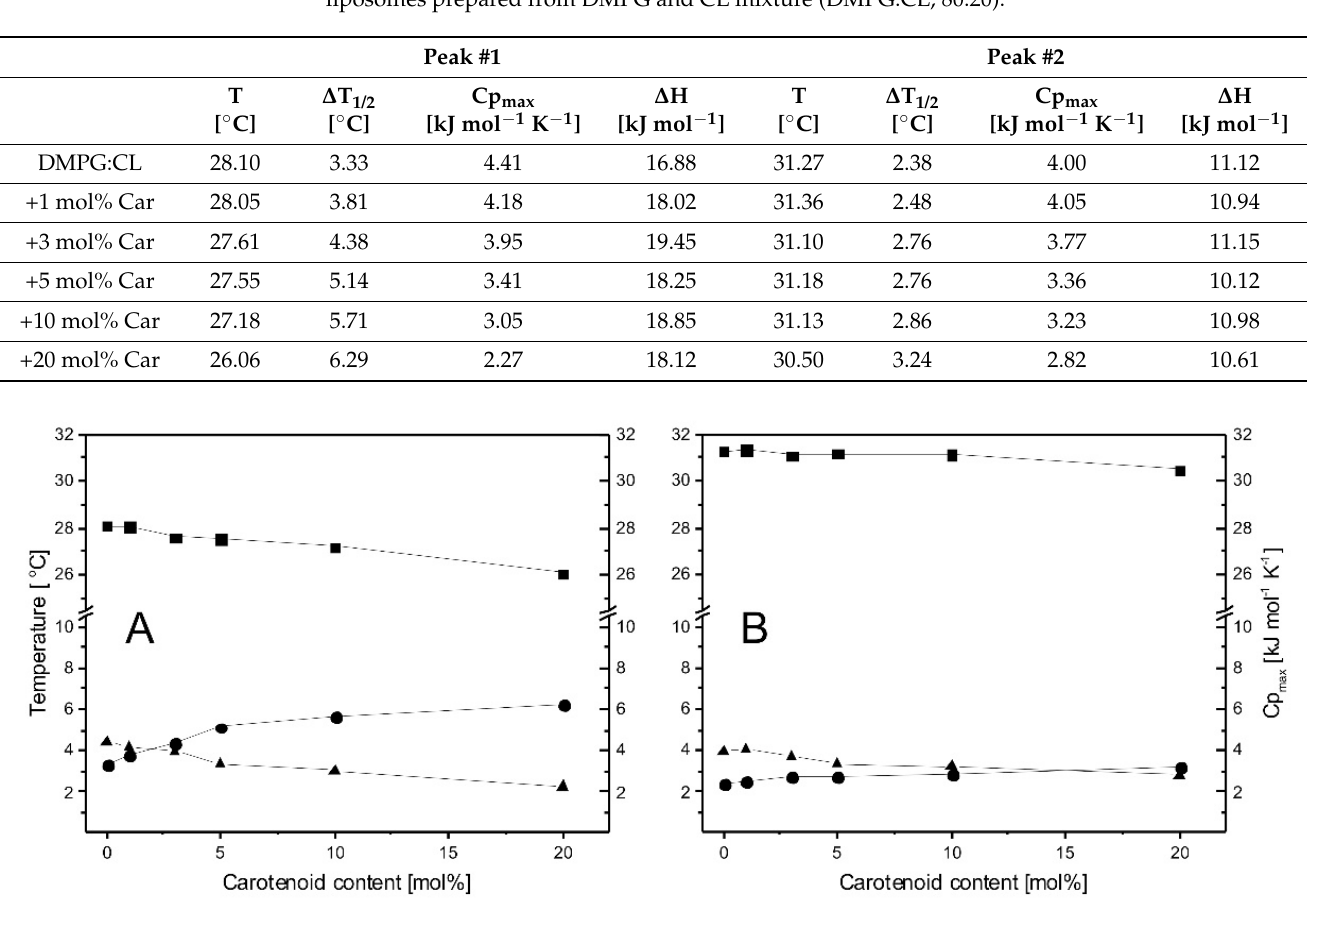
Figure 3. Plots of phase-transition temperatures T ( (cid:4) ), full-width at half-maximum ∆ T 1/2 ( • ), and peak height Cp max ( (cid:78) ) of deconvoluted peaks from representative DSC heating curves obtained for multilamellar liposomes prepared from DMPG and CL mixture (DMPG:CL, 80:20) as a function of carotenoid content. Sets of data for peak #1 and peak #2 are shown in panel ( A ) and ( B ), respectively.